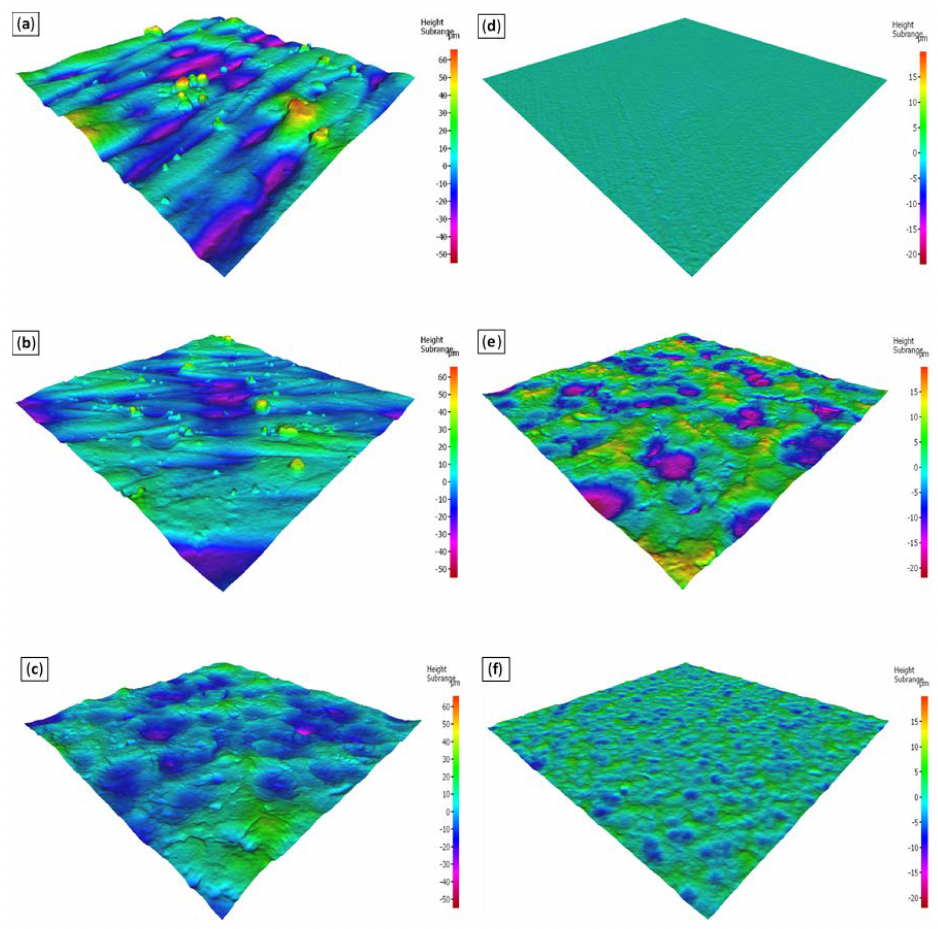
Figure 5. Three-dimensional (3D) surface texture of the AlSi10Mg samples: ( a ) AB (strip scan); ( b ) AB (up-skin); ( c ) AB + SP; ( d ) M; ( e ) M + HSP; and ( f ) M +